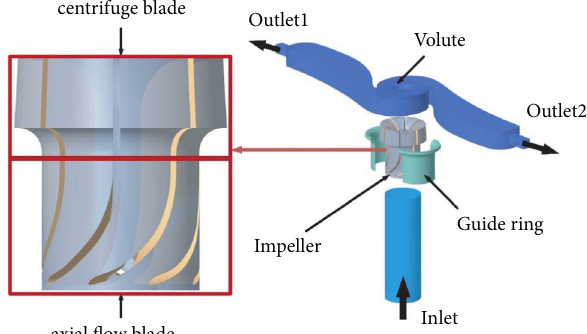
Figure 1: Design of single and double tongue volutes.